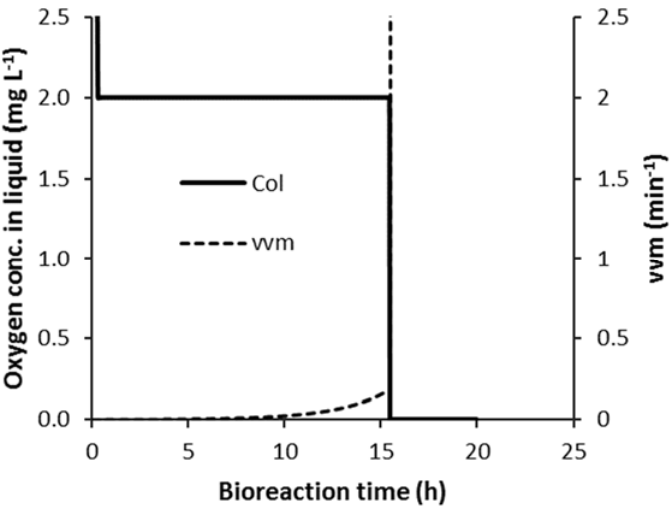
Figure 5. Effect of flooding on control strategy C1. ( Pag = 3.8 kW and flooding occurs at 15.51 h).